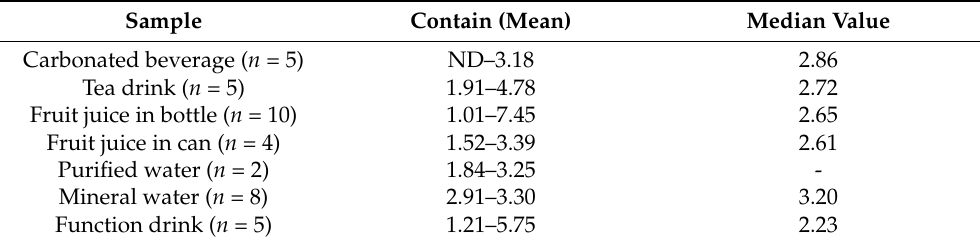
Table 3. The total PAE levels in common beverages ( µ mol L − 1